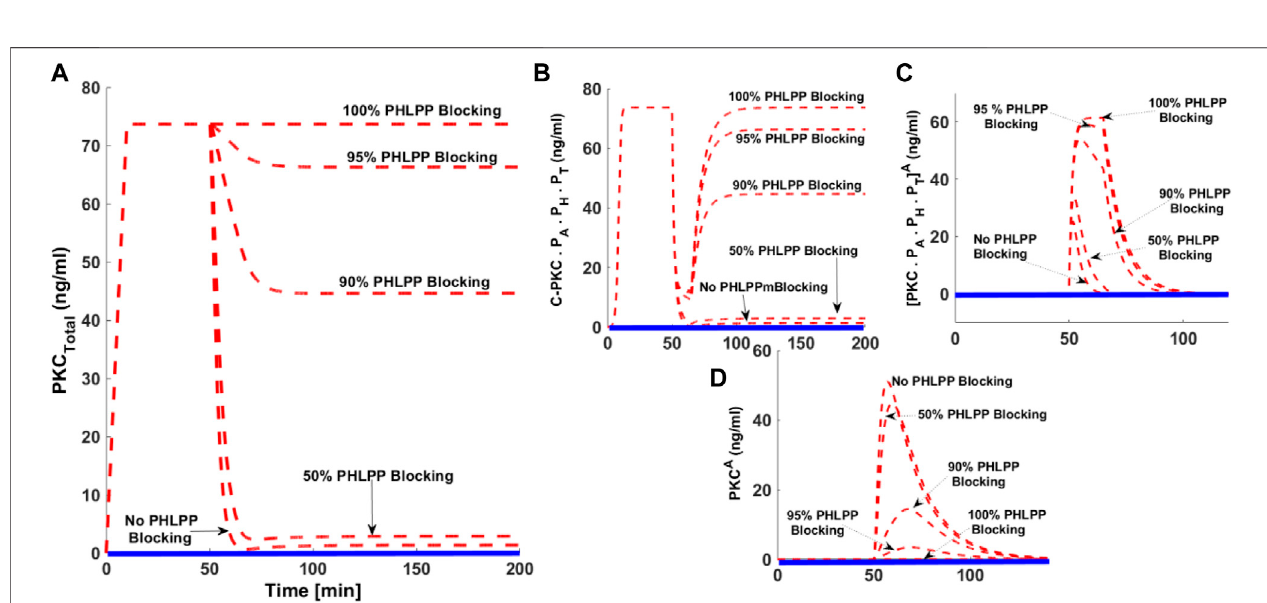
FIGURE 7 | The effect of PHLPP blocking on the down-regulation of cPKC enzyme after second messenger-induced activation. Here, dashed red lines show the stimulation whereas, the solid blue lines show the non-stimulation conditions. (A) The concentration of total PKC. These results indicate that after second messenger stimulation(secondmessengerDAG=0.5 nM,withpulsedurationof15 min),thecPKCiscompletelydownregulatedwhenthereisnoblockingofPHLPP.Theseresults show that degree of cPKC destabilization and its down-regulation is reduced in a dose-dependent manner with increasing the blocking levels of PHLPP. These results indicate thatwith100%blockingofPHLPPthereisnodown-regulation ofcPKC,evenwithhigh strengthsecondmessengerpulsestimulation. (B) concentration of C.PKC.P A .P H .P T with no blocking and different blocking levels of PHLPP. (C) Concentration of PKCP A . P H .P T . A with no PHLPP blocking and dose-dependent blocking (D) Concentration of PKC A with no PHLPP blocking and different levels of PHLPP blocking.